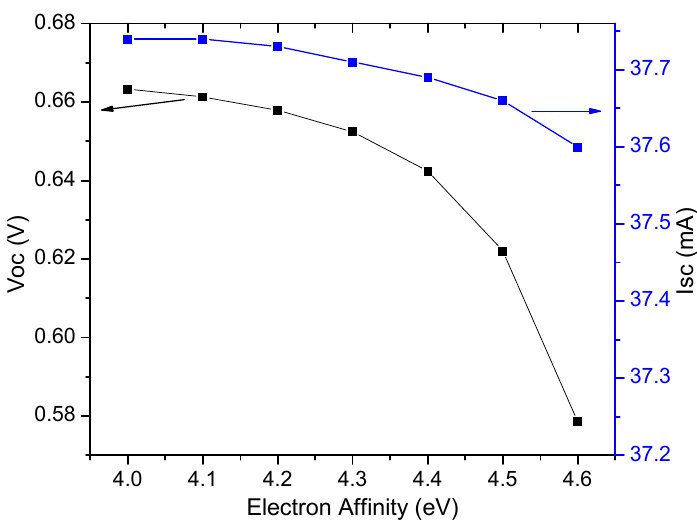
Figure 5. Effect of electron affinity of ZnO (bandgap: 3.27 eV) on the V OC and I SC of n-ZnO/p-Si solar cell using PC1D simulations.